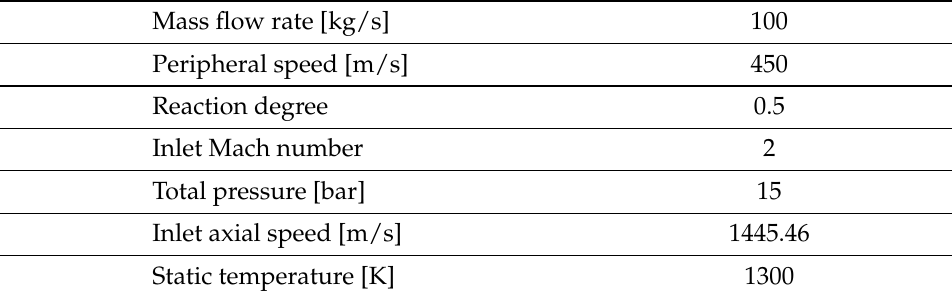
Table 1. Input parameters for the reference design stage.